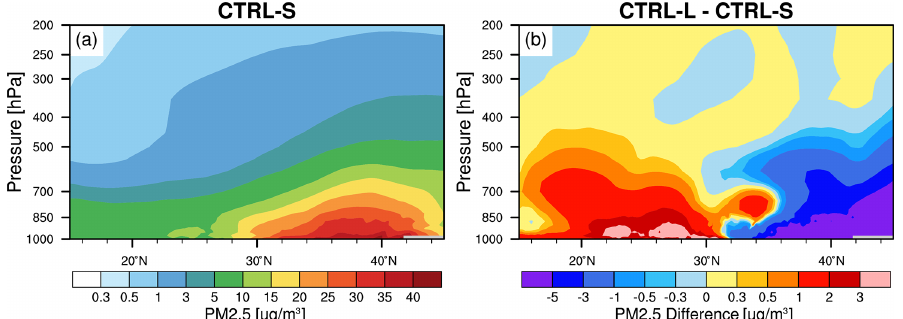
Figure 7. The latitude–height cross section of (a) total PM 2 . 5 averaged between 105 and 122 ◦ E for June and July 2017 from the CTRL-S experiment, and (b) the difference between CTRL-L and